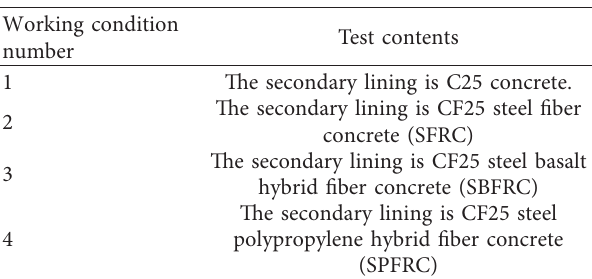
Figure 4: The geodetic structure of the line area. Table 5: Test groups.